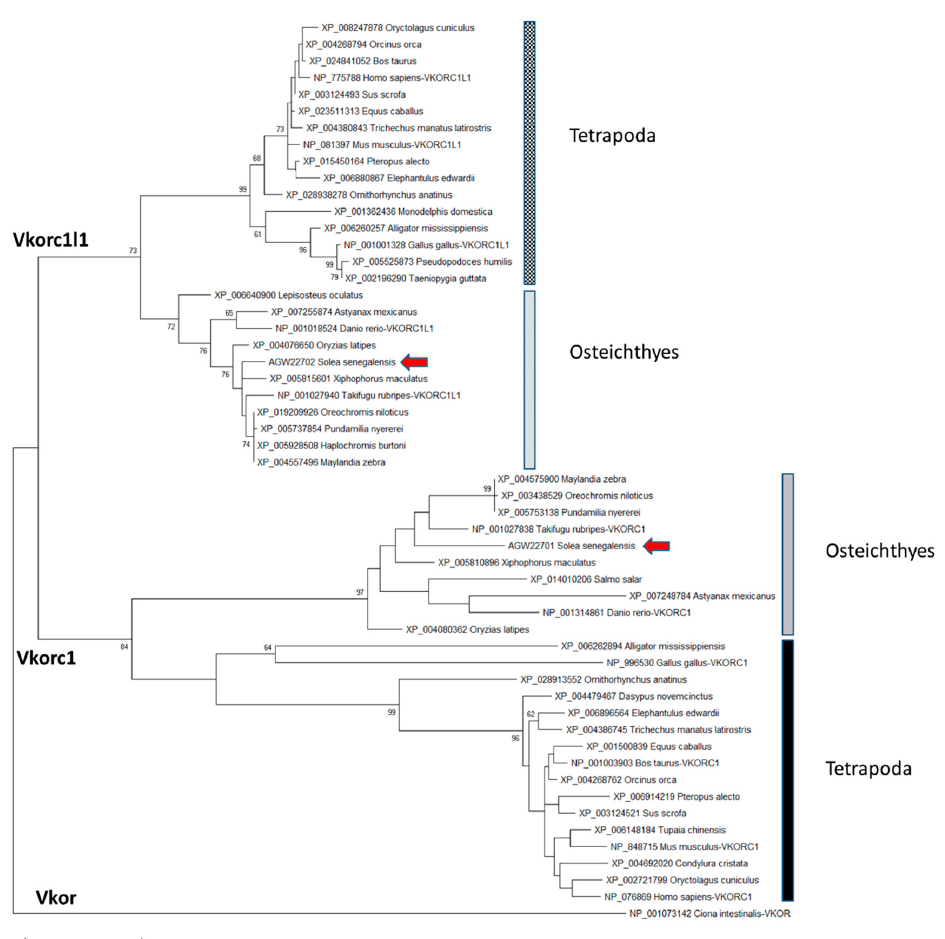
Figure 1. Maximum likelihood phylogenetic tree of vitamin K epoxide reductases